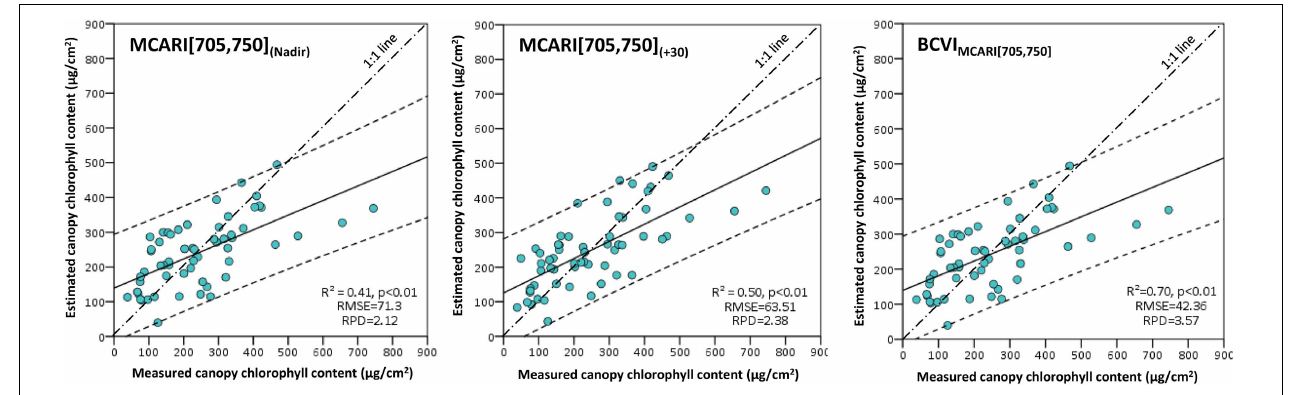
FIGURE 11 | Scatterplots between measured canopy chlorophyll content and estimated canopy chlorophyll content based on the MCARI[705,750] ( Nadir ) , MCARI[705,750] ( + 30 ) , and BCVI MCARI [ 705 , 750 ] . The solid lines indicate the regression fitting lines, the dash lines indicate the 95% confidence intervals of prediction, the long and short dash lines indicate 1:1